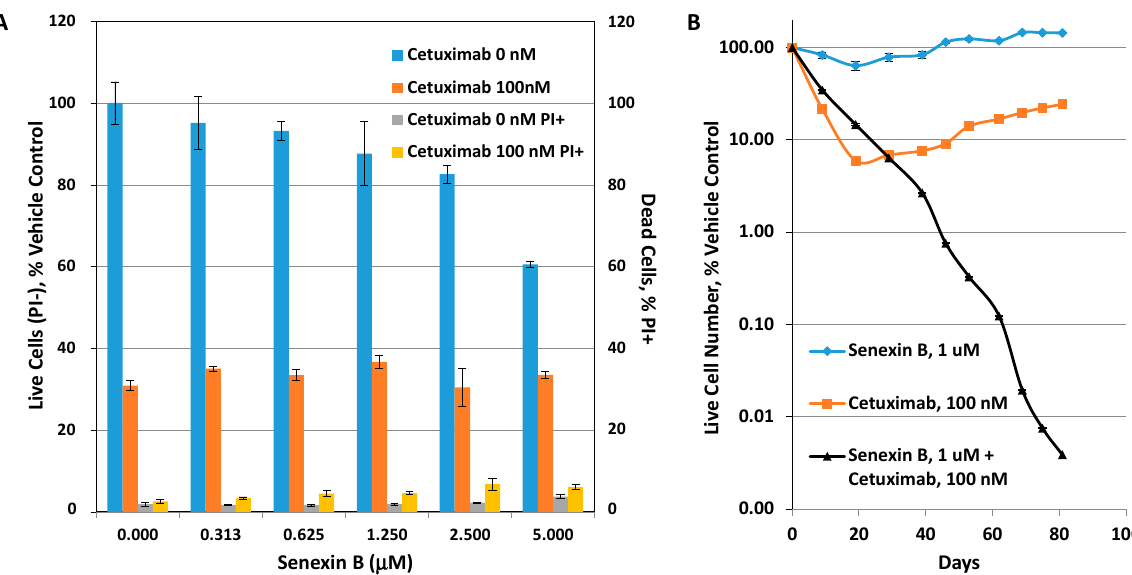
Figure 5. Effects of senexin B on the development of cetuximab resistance in SW48 colon carcinoma cells. ( A ) Effects of 7-day treatment with the indicated concentrations of Senexin B combined with vehicle or 100 nM cetuximab on the number of live (PI-) cells relative to vehicle control and the fraction of dead (PI+) cells. ( B ) Effects of prolonged treatment with senexin B (1 µM), cetuximab (100 nM) or senexin B plus cetuximab combination. Cell numbers for each time point are shown relative to untreated cells (mean ± SEM of duplicate measurements; error bars at most points are smaller than symbol size).